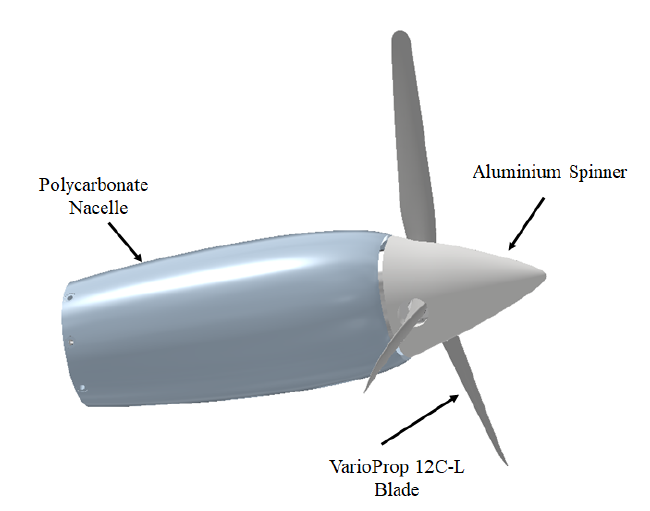
Figure 2. Layout of the propeller model.